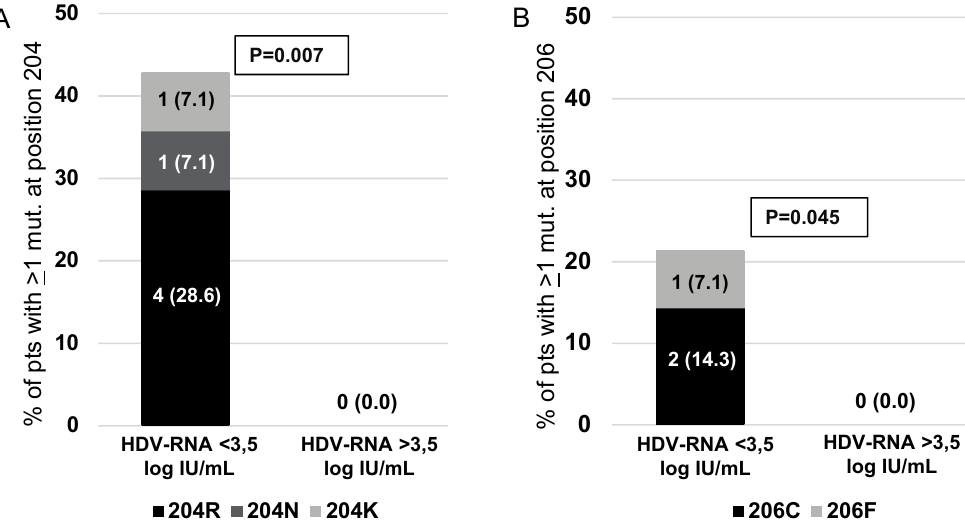
Figure 4. Association of mutated positions in HBsAg with levels of HDV-RNA. The histogram reports the percentage of patients with at least one mutation at HBsAg position 204 ( A ) and 206 ( B ) calculated in the group of patients with HDV-RNA <3.5 log IU/mL ( n = 14) and with HDV-RNA >3.5 log IU/mL ( n = 17). The prevalence of each mutation, detected at HBsAg positions 204 and 206, is reported in each bar. Statistically significant differences were assessed by Chi Squared Test based on 2 × 2 contingency